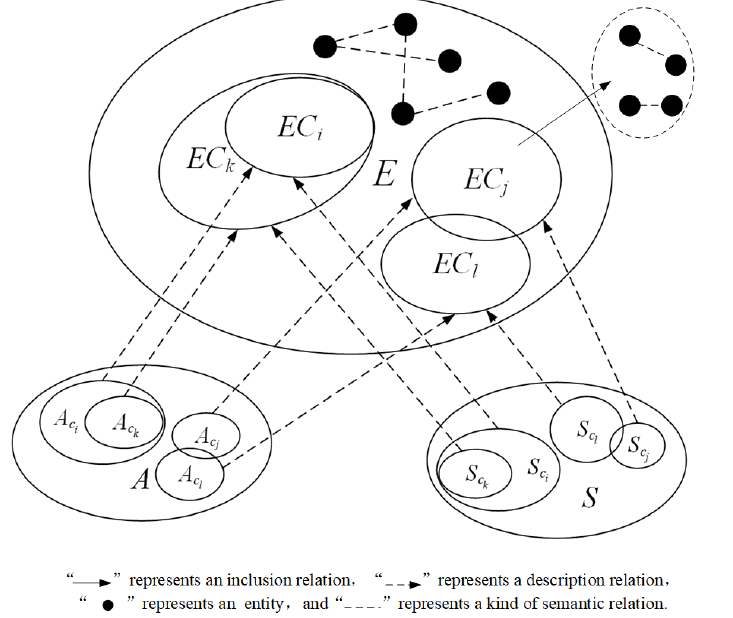
Figure 5. Relations among entities, entity classes, attributes, and